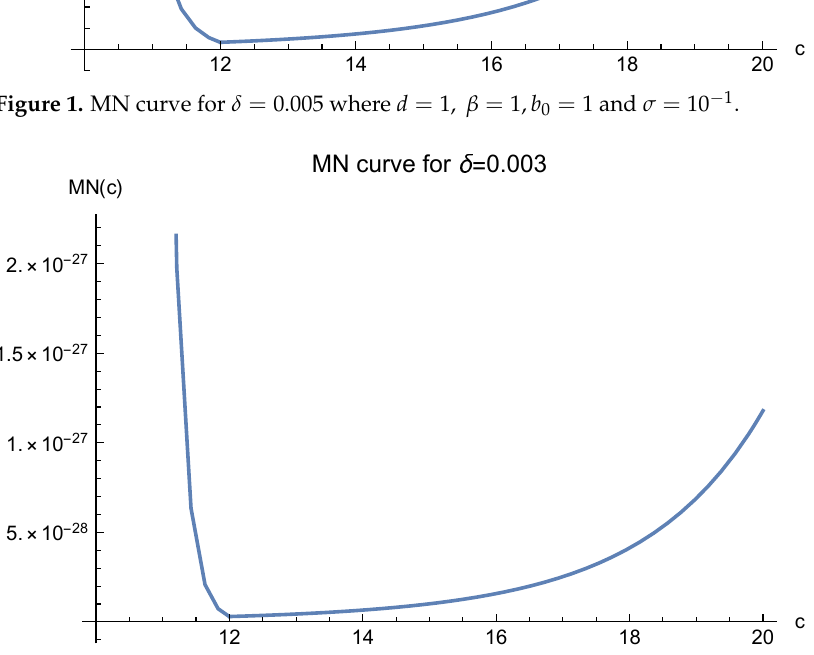
Figure 2. MN curve for δ = 0.003 where d = 1, β = 1, b 0 = 1 and σ = 10 − 1